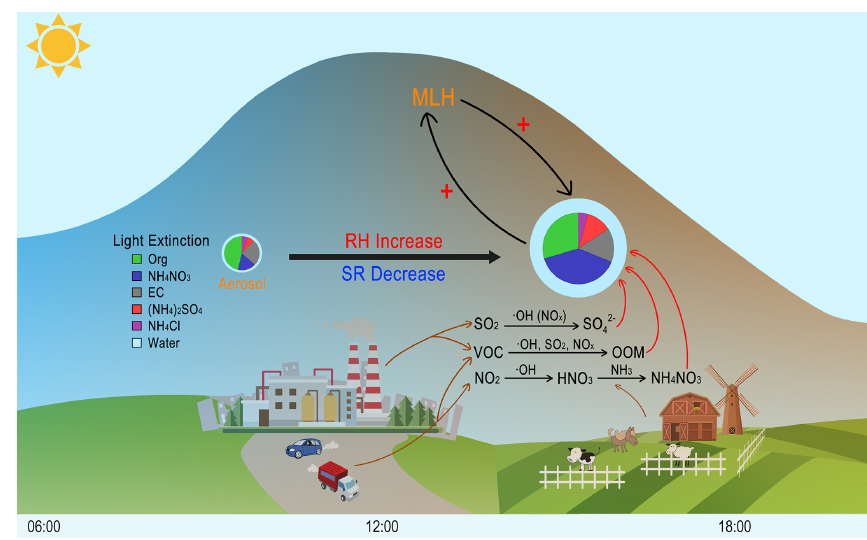
Figure 9. A schematic picture illustrating the process of rapid aerosol mass growth and enhanced light extinction in Beijing. The plus symbols represent the strengthening of a specific process. At the presence of aerosols during afternoon time in Beijing, the intensity of solar radiation reaching the surface will be decreased and relative humidity will be increased. As a result, the development of boundary layer will be suppressed, and the concentrations of aerosol precursors (e.g. SO 2 , NO 2 , VOC) will be increased. In turn, the secondary production of these sulfate, nitrate and oxygenated organic compounds will be enhanced due to increased concentrations and partitioning of these compounds into the aerosol phase. The increased formation of secondary aerosol mass will reduce solar radiation further and the haze formation increased, as shown in pie charts that the light extinction fraction of aerosol changed from organic to nitrate. Noting that during intensive haze periods, nitrate and its contribution to light extinction contribution increased